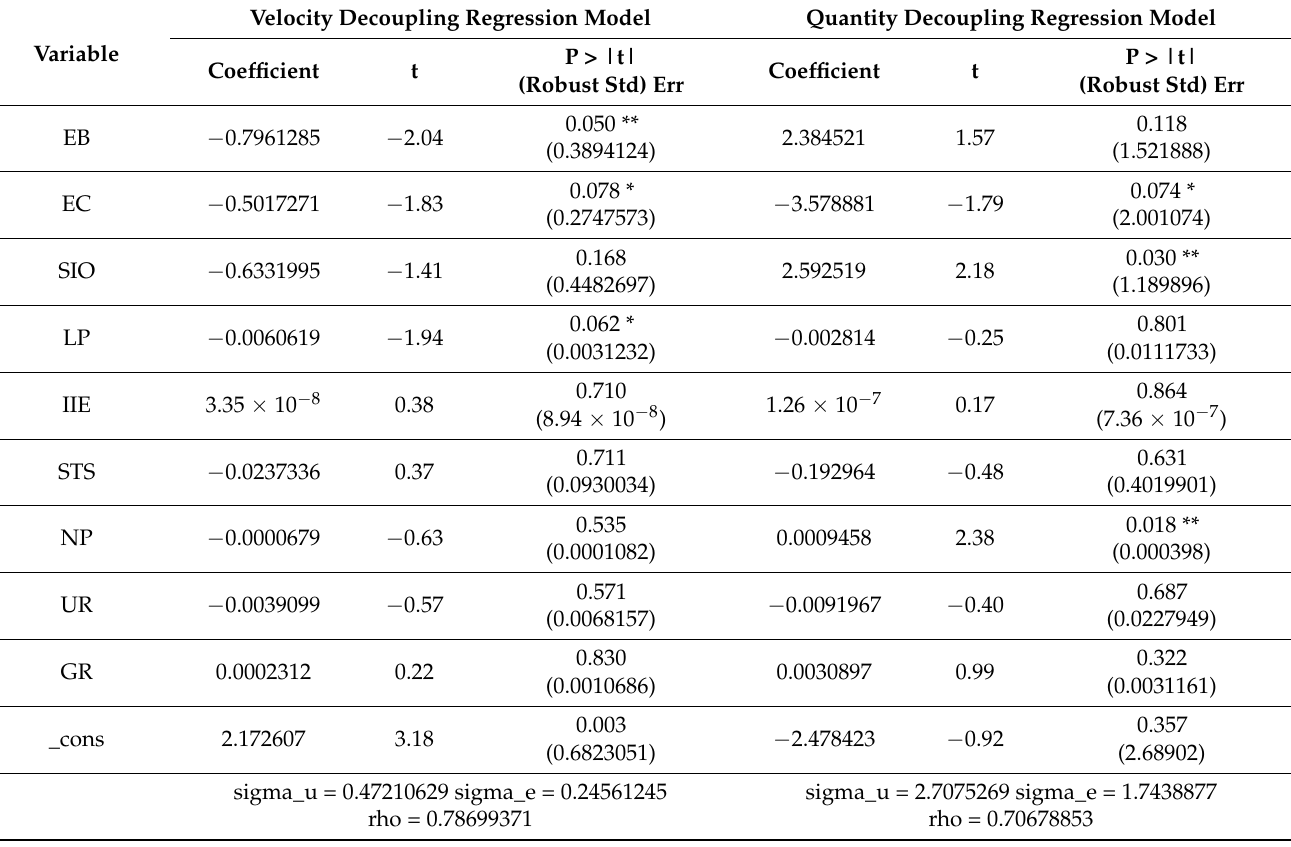
Table 7. Regression results of the